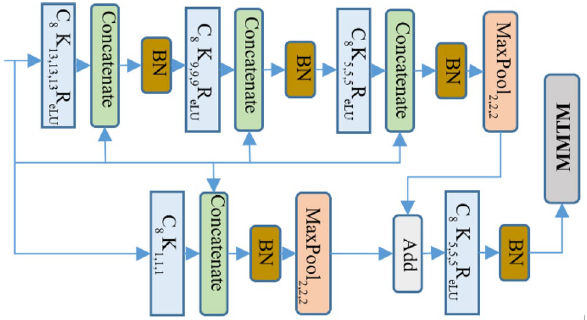
Figure 4. Detailed overview of the dense residual block of audio and video network (the value related to first block of video network). The symbol ‘C’ indicates the convolutional, ‘K’ indicates kernel size, ‘BN’ indicates batch normalization, ‘R eLU ’ indicates the rectified linear unit and MMTM indicates multimodal transfer module for multimodal information fusion. The lower case value indicates the given value to corresponding symbol.